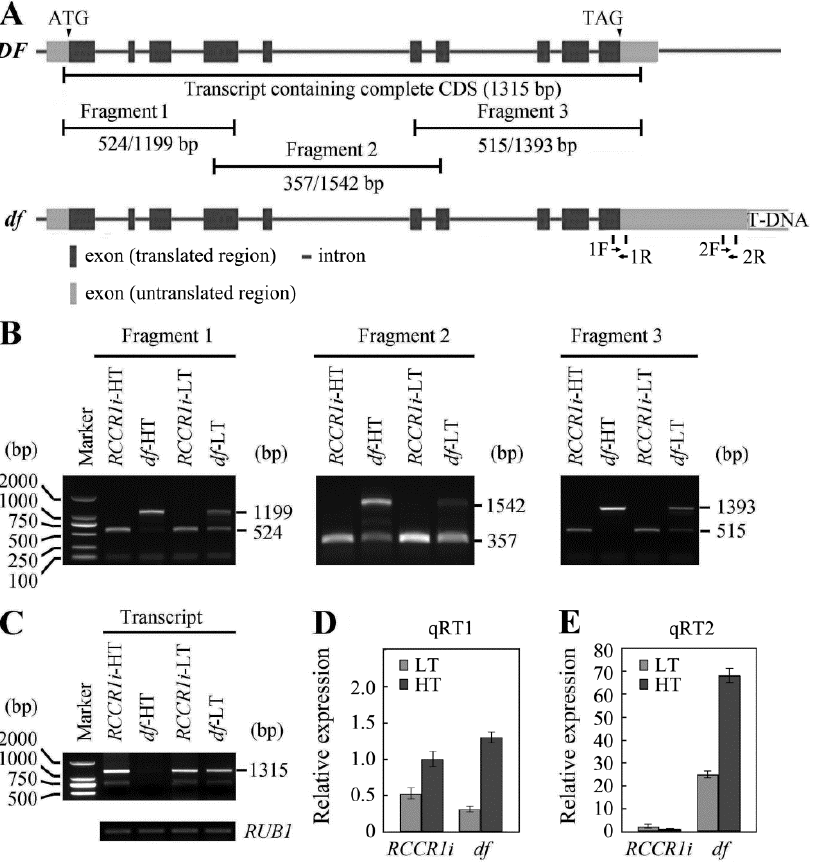
Figure 6. Temperature-dependent pre-mRNA splicing in df plants. ( A ) Distribution of primer pairs used for (q) RT-PCR along the OsGPI8 gene. The lengths (bp) of predicted cDNAs / genomic DNAs are indicated. ( B ) RT-PCR products of di ff erent regions of OsGPI8 transcripts. Bands corresponding to predicted cDNAs and genomic DNA are indicated. ( C ) RT-PCR products for transcripts which contain the complete coding domain sequence. Bands corresponding to predicted cDNAs are indicated. ( D ) qRT-PCR analysis of total OsGPI8 transcripts using the primer pair of 1F and 1R indicated in ( A ) in shoots grown at di ff erent temperatures. ( E ) qRT-PCR analysis of OsGPI8 transcripts with the longer 3 (cid:48) -UTR using the primer pair of 2F and 2R indicated in ( A ) in shoots grown at di ff erent temperatures. Relative expression was normalized to that of the reference gene OsRUB1 (internal control). Bars show standard deviations of the repeats. Each assay was run in duplicate for three independent biological repeats. HT = higher temperature (29–33 ◦ C). LT = lower temperature (19–23 ◦ C).